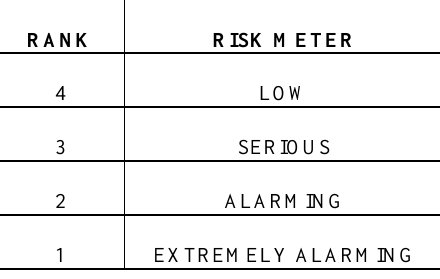
Table 11. Ranking food insecure zones